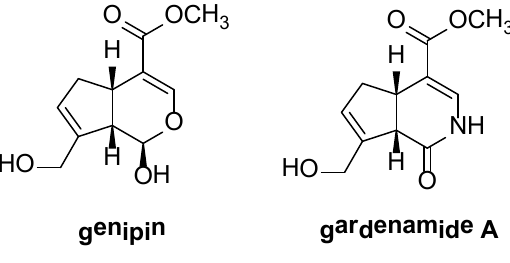
Figure 1. Chemical structures of genipin and gardenamide